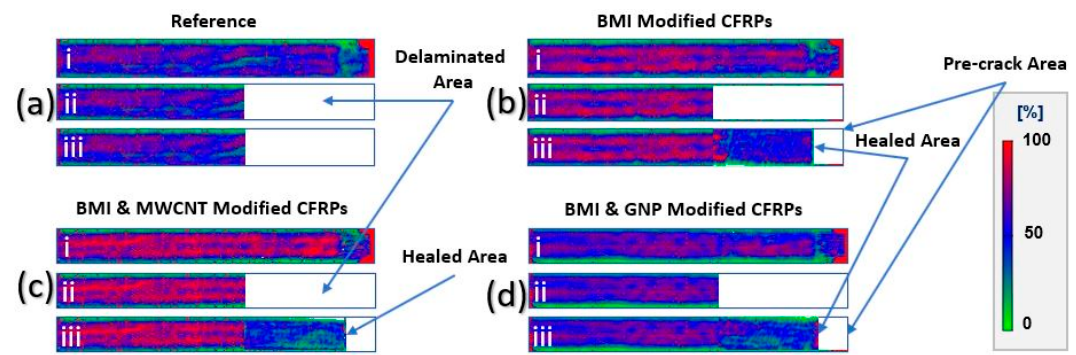
Figure 8. C-scan inspection images of ( a ) a reference, ( b ) a BMI-modified CFRP, ( c ) a BMI- and MWCNT-modified CFRP and ( d ) a BMI- and GNP-modified CFRP, prior to Mode I testing ( i ), after fracture ( ii ) and after the activation of the healing process ( iii ).